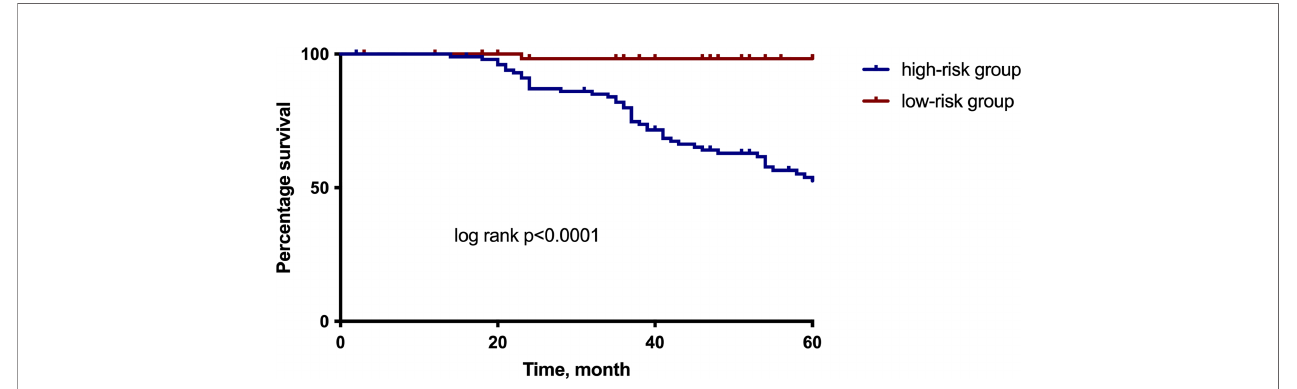
FIGURE 5 | The 5-year MFS for NSCLC patients according to the group of low and high risk of distant metastasis. Log rank test. MFS,